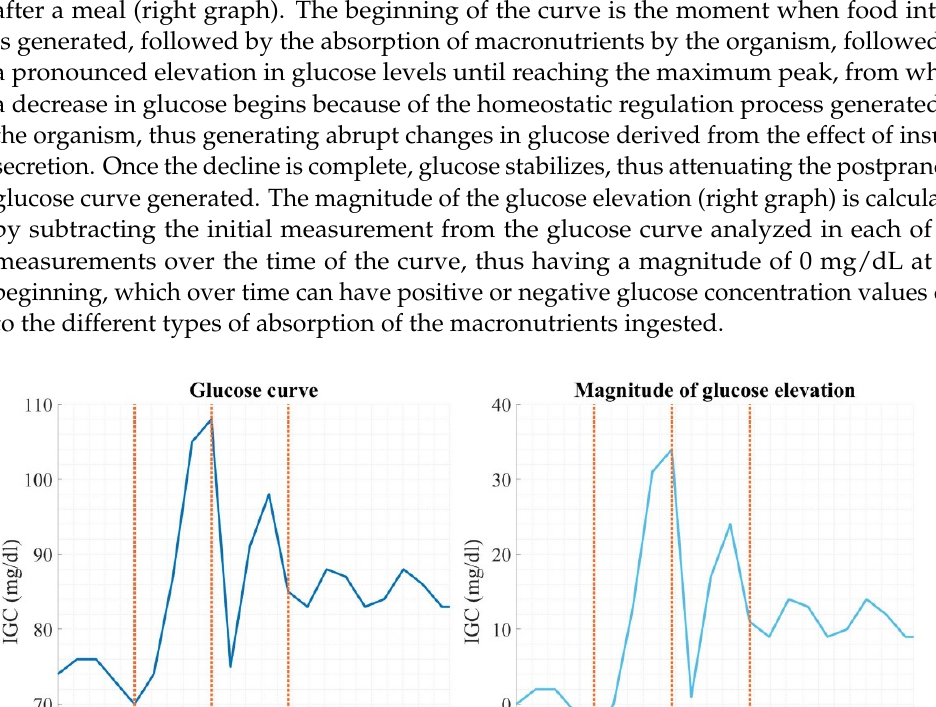
Figure 2. Glucose measurements in each test developed. Quantitatively, the average variation between each of the tests is described in Table 4, where the glucose average data, the glucose management indicator (based on that pro- posed by Leelarathna et al. [28]), and the glucose coefficient of variation (considering that submitted by Rodbard [29]) are presented. These data were calculated for total glucose measurements in each test performed over the 14 days of size. The results demonstrate how a higher glucose variation coefficient correlates with lower glucose concentrations and a glucose management indicator. This phenomenon is visible when comparing Test 1 results with those in Test 3.